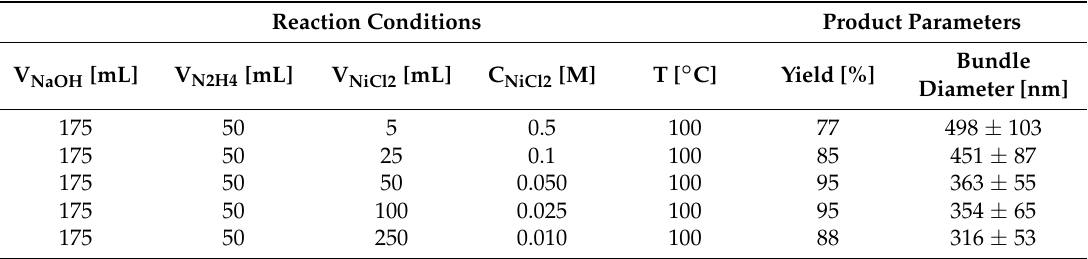
Table 3. The influence of NiNW precursor concentration on the product parameters.